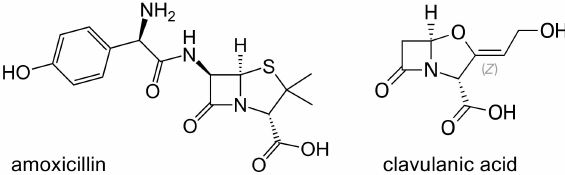
Figure 1. Chemical structures of amoxicillin and clavulanic